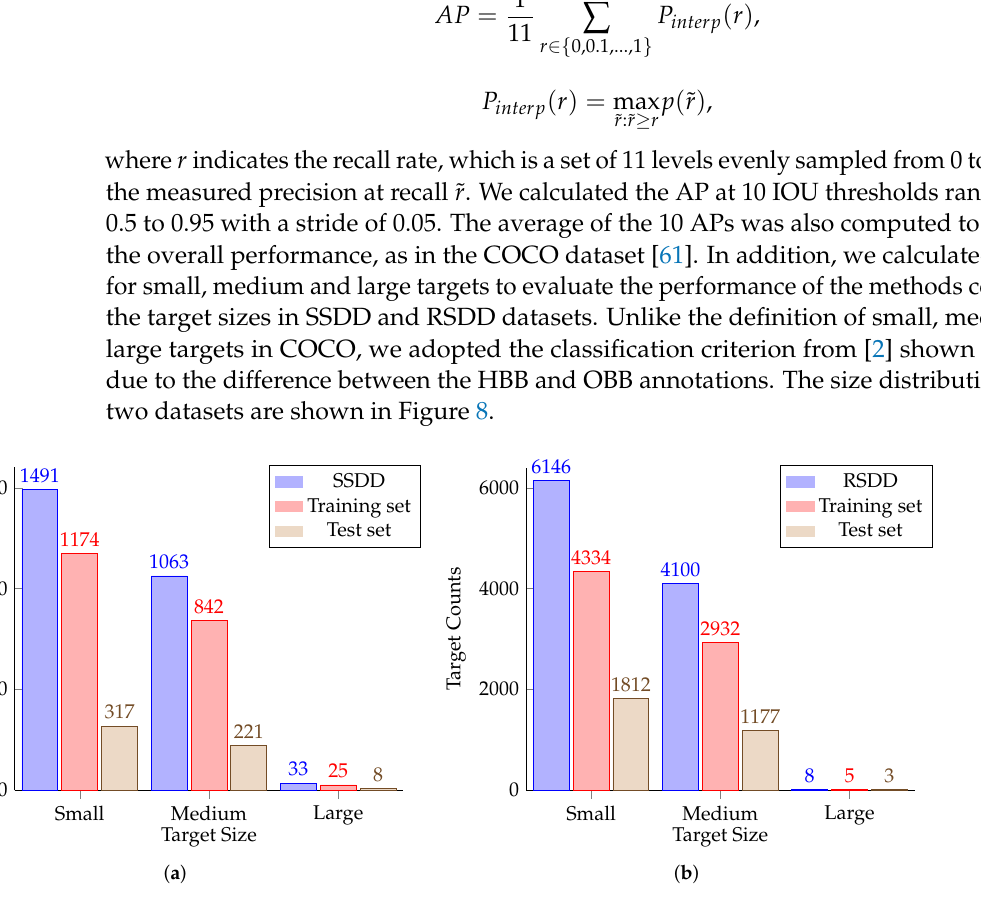
Figure 8. Target size distributions of ( a ) SSDD dataset and ( b ) RSDD